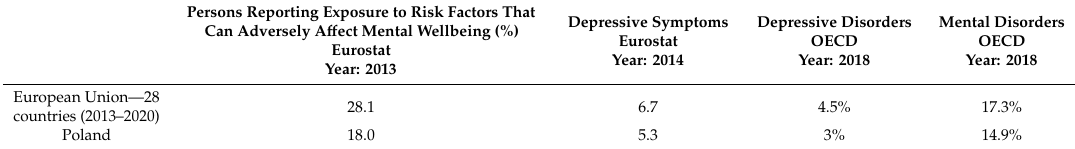
Table 3. Data related to mental health (Eurostat 2013, 2014; OECD